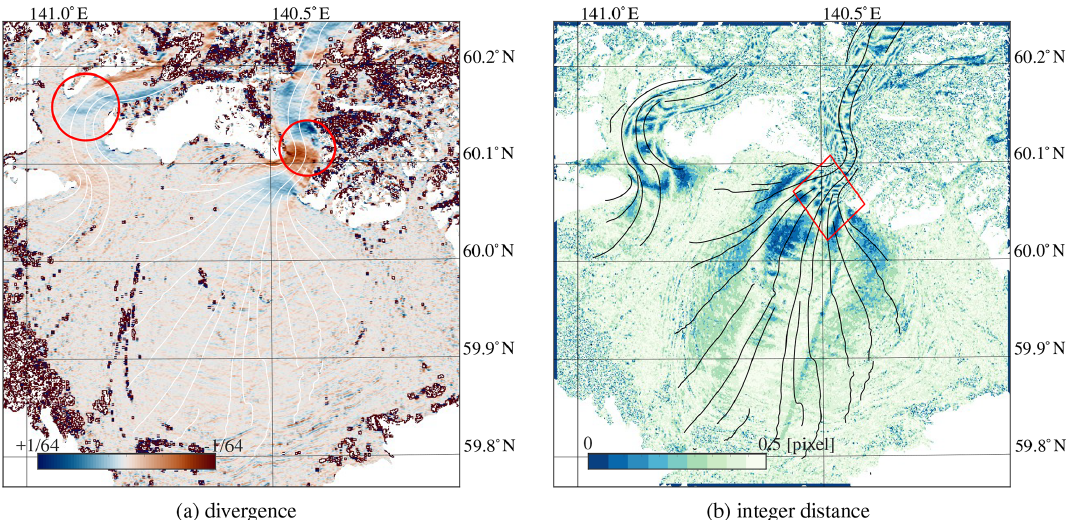
Figure 10. Estimated surface divergence, derived from the estimated velocity (Fig. 5a). The red circles indicate regions where significant crevassing is present (Fig. 6b). The modulus from a combination of sub-pixel displacements (Fig. D2a, b) is shown in (b) . The red diamond indicates a pattern that is similar to the absolute correlation value as shown in Fig. 9a.